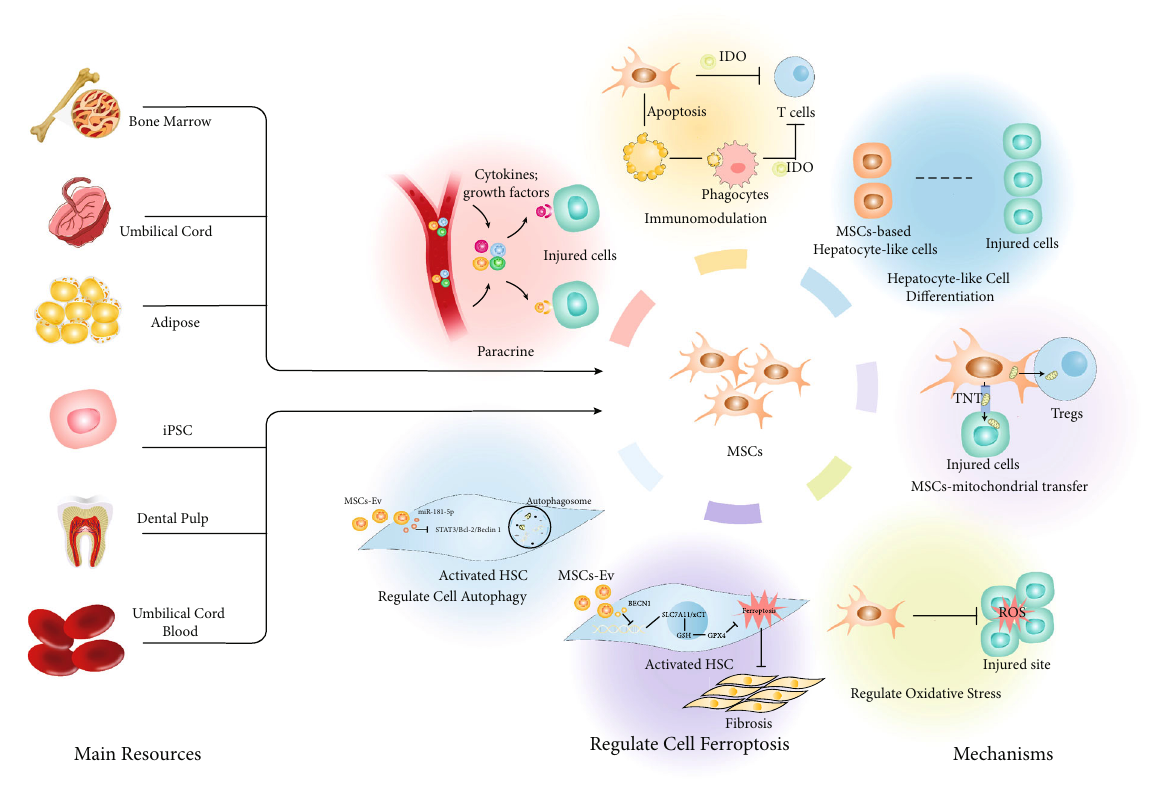
Figure 1: Main resources and underlying therapeutic mechanisms of MSCs in treating liver fi brosis/cirrhosis. MSCs are commonly obtained from bone marrow, umbilical cord blood, adipose tissue, and iPSC. MSCs exert therapeutic e ff ects through paracrine, immunomodulation, hepatocyte-like cell di ff erentiation, oxidative stress regulation, cell ferroptosis regulation, cell autophagy regulation, and MSCs- mitochondrial